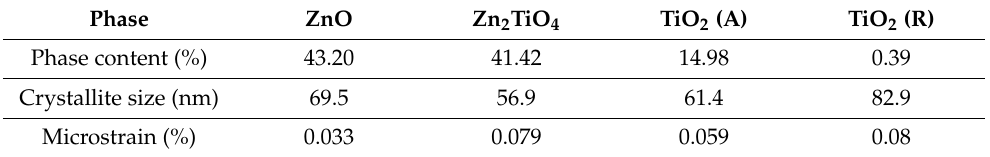
Table 2. The phase composition, crystallite size, and microstrain of ZT–1 by Rietveld refinement.